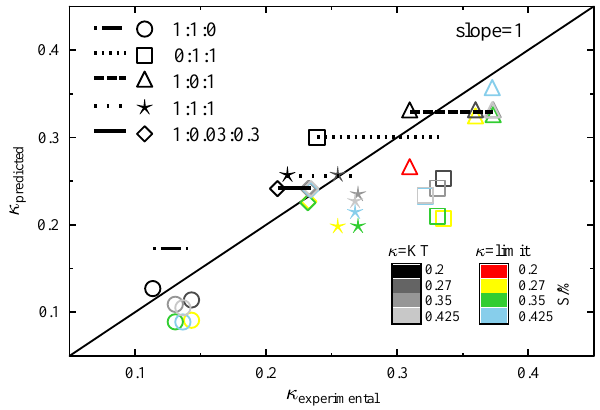
Figure 4. Predicted κ as a function of experimentally derived κ at different supersaturation ( S ) for the binary and ternary particle mix- tures of LEV, MNC, and KS. κ is predicted by applying the volume mixing rule and based on single-component experimentally derived κ at each S including solubility limitations ( κ = limit; color scale), κ calculated from Köhler theory ( κ = KT; gray scale), and κ assum- ing no solubility limitations (horizontal lines). Note that the hori- zontal lines span the range of experimentally derived κ . The black diagonal line represents a slope of 1 in the derived vs.